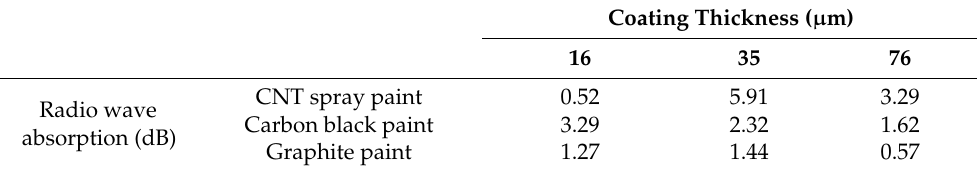
Table 1. 28 GHz band radio wave absorption.